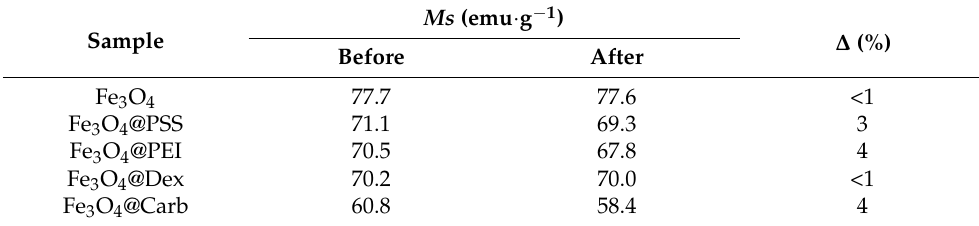
Table 3. Magnetic properties of IONs coated with various modifiers before and after sorption of DOX.